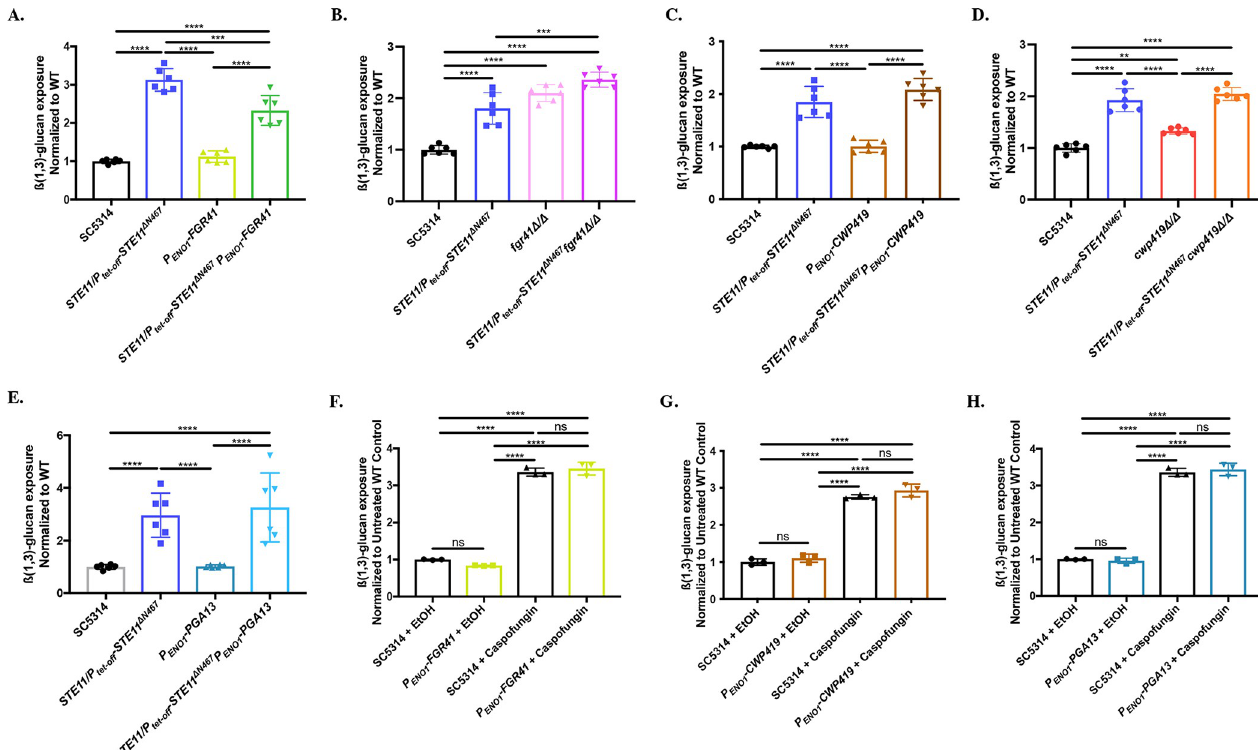
Fig 5. FGR41 overexpression and deletion modulates Ste11 Δ N467 -induced, but not caspofungin-induced, ß(1,3)-glucan unmasking. (A-E) Overnight cultures of cells were stained with anti-ß(1,3)-glucan antibody and a phycoerythrin-conjugated secondary antibody to assess the levels of ß(1,3)-glucan exposure by flow cytometry. (A) ß(1,3)-glucan exposure during FGR41 overexpression. (B) ß(1,3)-glucan exposure in FGR41 deletion mutants. (C) ß(1,3)- glucan exposure during CWP419 overexpression. (D) ß(1,3)-glucan exposure in CWP419 deletion mutants (E) ß(1,3)-glucan exposure during PGA13 overexpression. (n = 3 biological replicates with 1 technical replicate for each mutant analyzed)( �� p < 0.005, ��� p < 0.0005, ���� p < 0.0001, by one-way ANOVA). (F-H) Cells grown to mid-log phase were exposed to 46.9ng/ml of caspofungin for 30 minutes and ß(1,3)-glucan exposure was subsequently assessed via flow cytometry. (F) ß(1,3)-glucan exposure of FGR41 overexpression cells treated with sublethal concentrations of caspofungin. (G) ß(1,3)-glucan exposure of CWP419 overexpression cells treated with sublethal concentrations of caspofungin. (H) ß(1,3)-glucan exposure of PGA13 overexpression cells treated with sublethal concentrations of caspofungin. (n = 3 biological replicates)(ns = not significant, ���� p < 0.0001, by one-way ANOVA).